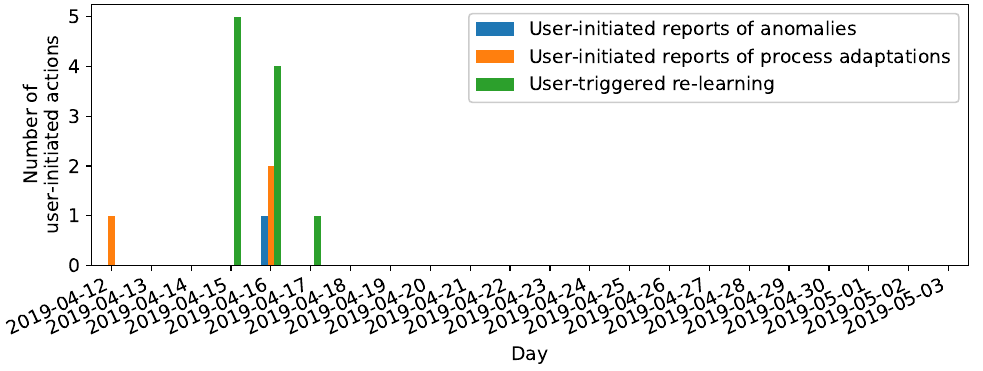
Figure 14. User-initiated actions across time (cf. Assumption 5): Anomaly reports, process adaptation reports and user-triggered relearning. Similar to clusters of anomalies in Figure 9, user-initiated actions cluster around the 16th of April, where damage of the grinding wheels was visually